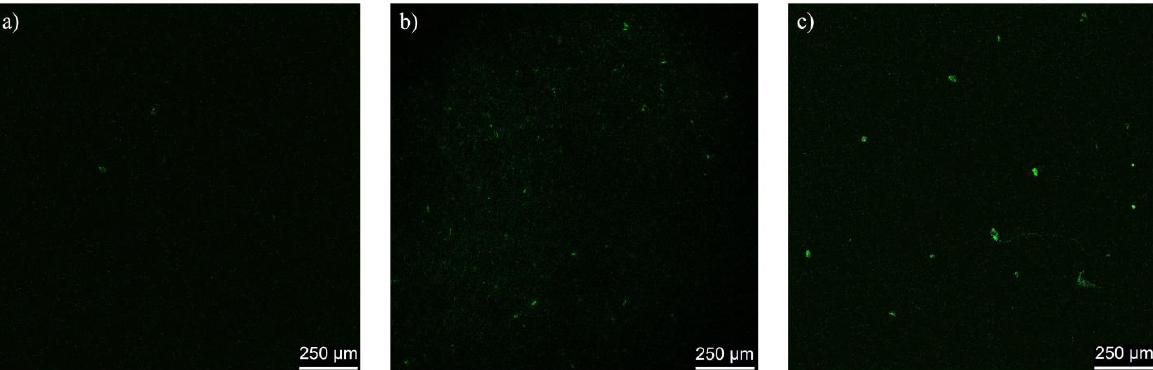
Figure 7. Rat brain slices after administration of ( a ) free rhodamine B; ( b ) plain rhodamine B-loaded cerasomes; ( c ) Tween 80 cerasomes labeled with rhodamine B.